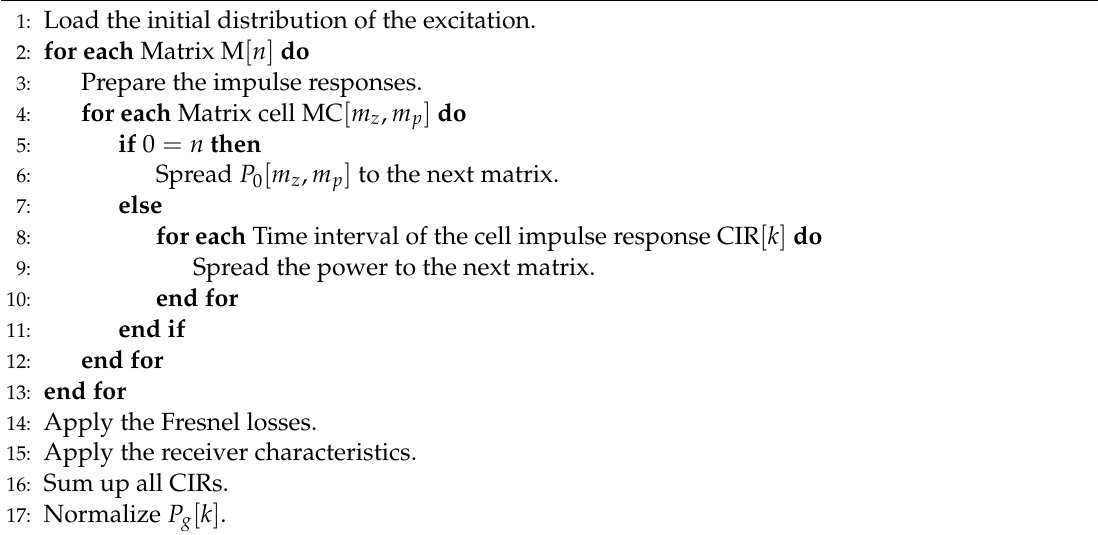
Algorithm 1 Simulation of the power propagation in the